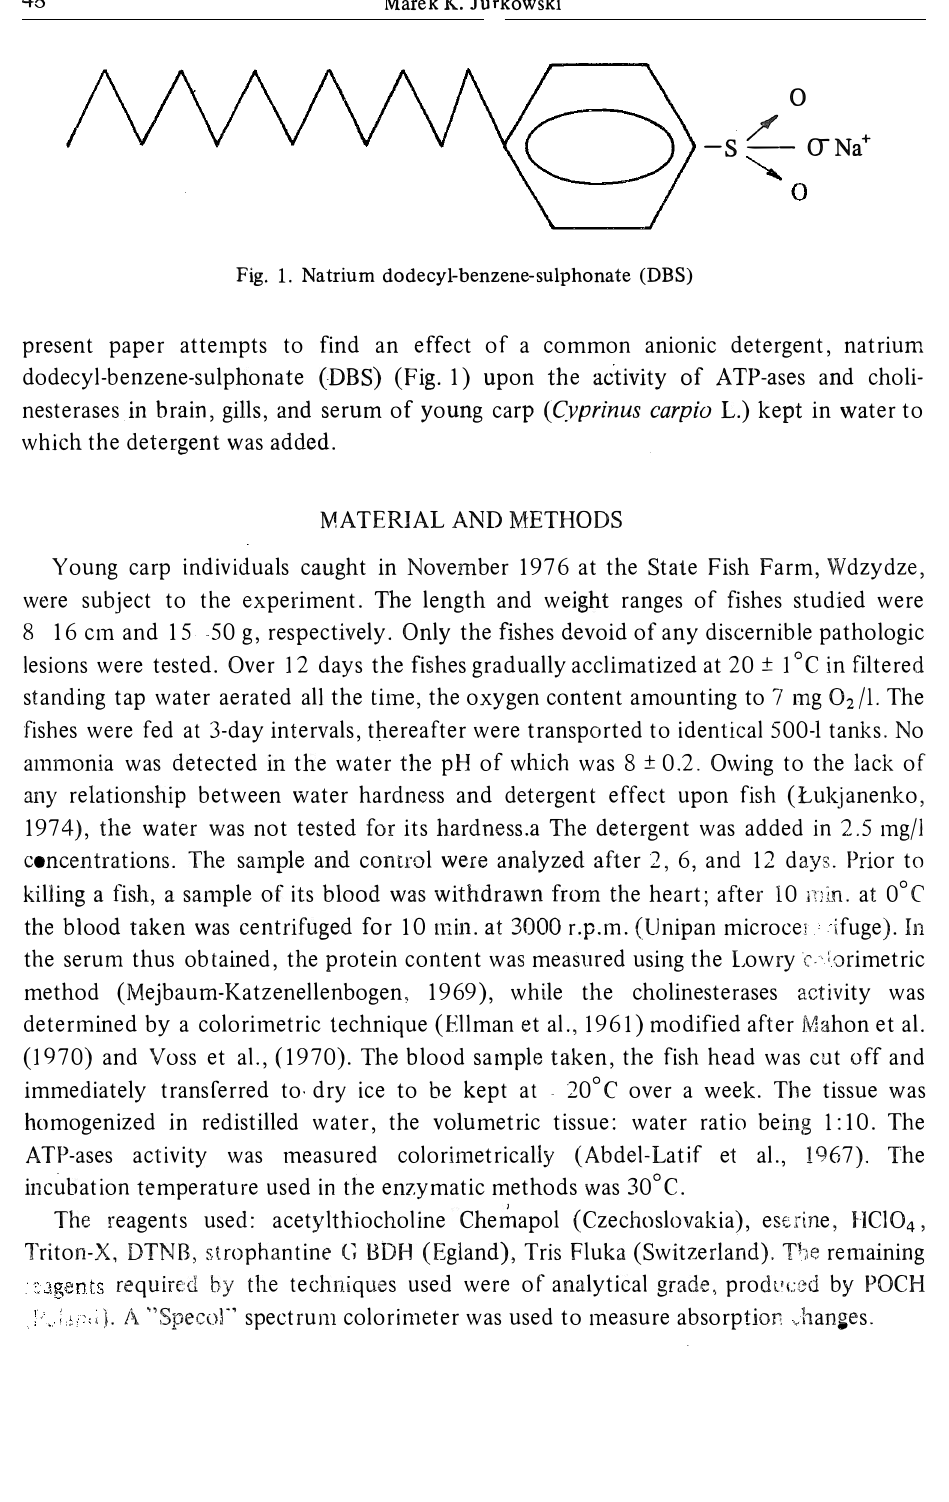
Fig. 1. Natrium dodecyl-benzene-sulphonate (DBS)